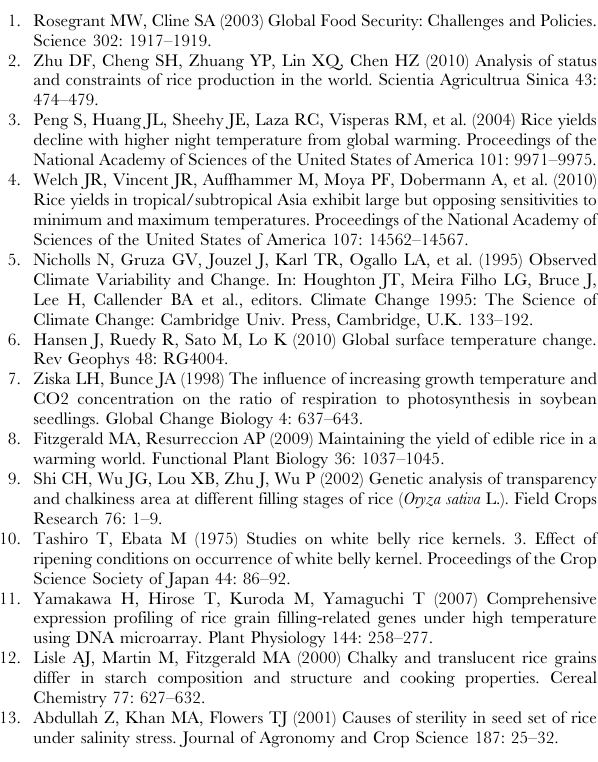
Table S1 Average of flowering day and milling quality across seasons. Table S2 Weather data of grain filling stage on 2005DS and